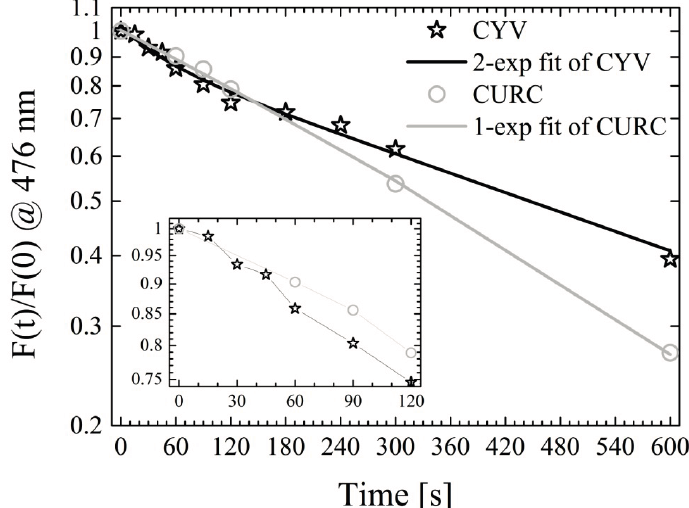
Figure 8. Diphenylisobenzofuran fluorescence as a function of time. Both CYV (black stars) and CURC (grey dots), upon illumination, produce ROS, which induce oxidation of the highly fluorescent compound diphenylisobenzofuran into the non-fluorescent compound o